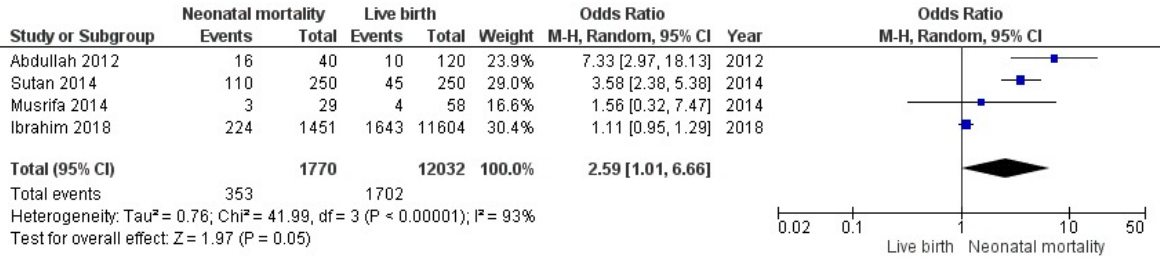
Figure 3. Association between incomplete ANC and neonatal mortality.